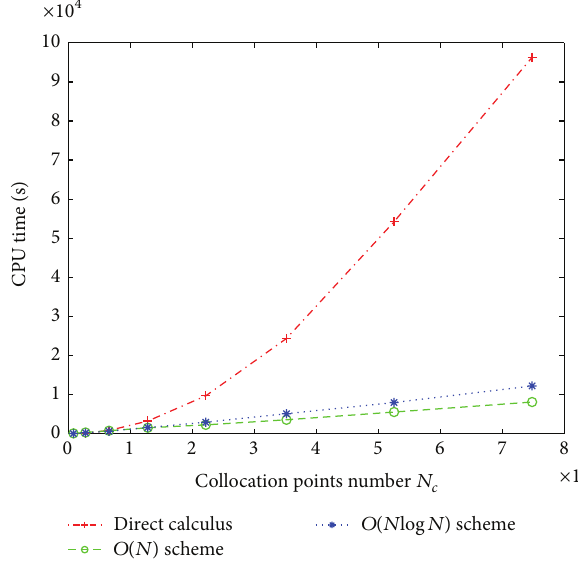
Figure 13: CPU time of the two schemes versus the level for 𝑁 𝑐 = 351918 .